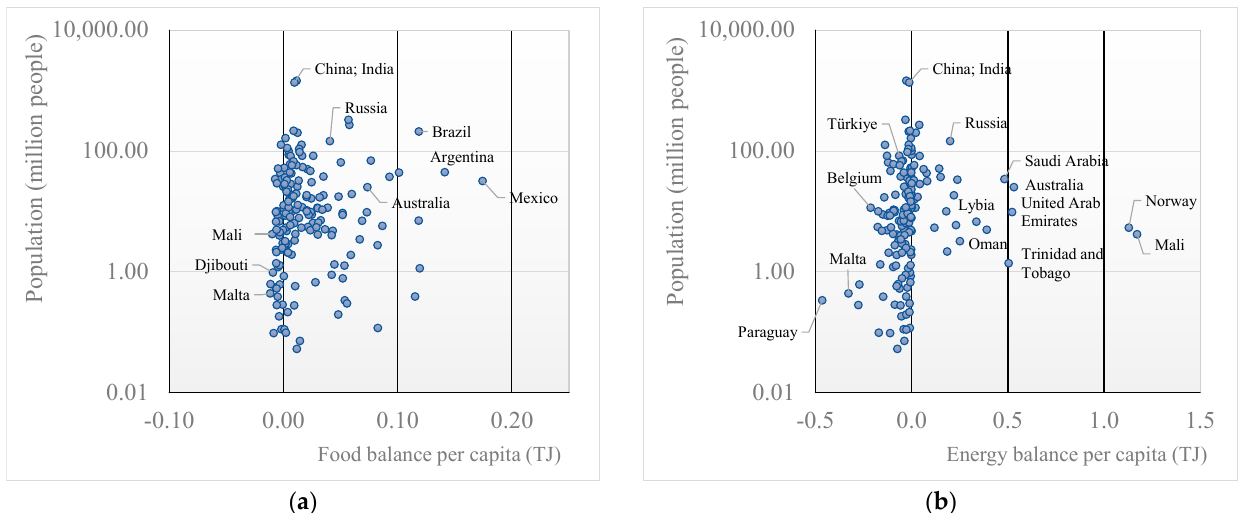
Figure 5. ( a ) Food balance per capita vs. population; ( b ) Energy balance per capita vs. population (2019).